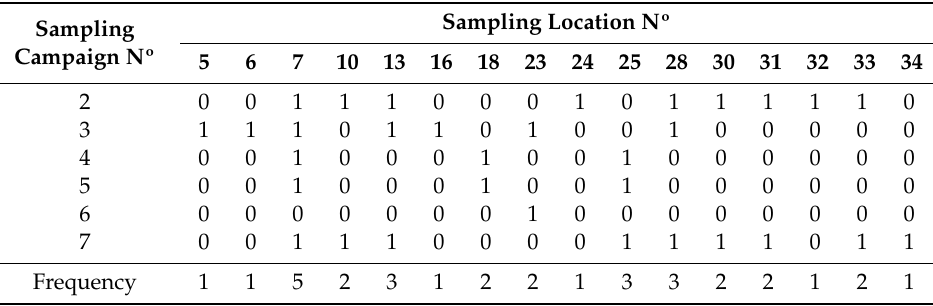
Table 5. Frequency of sampling points with higher deposition flux.